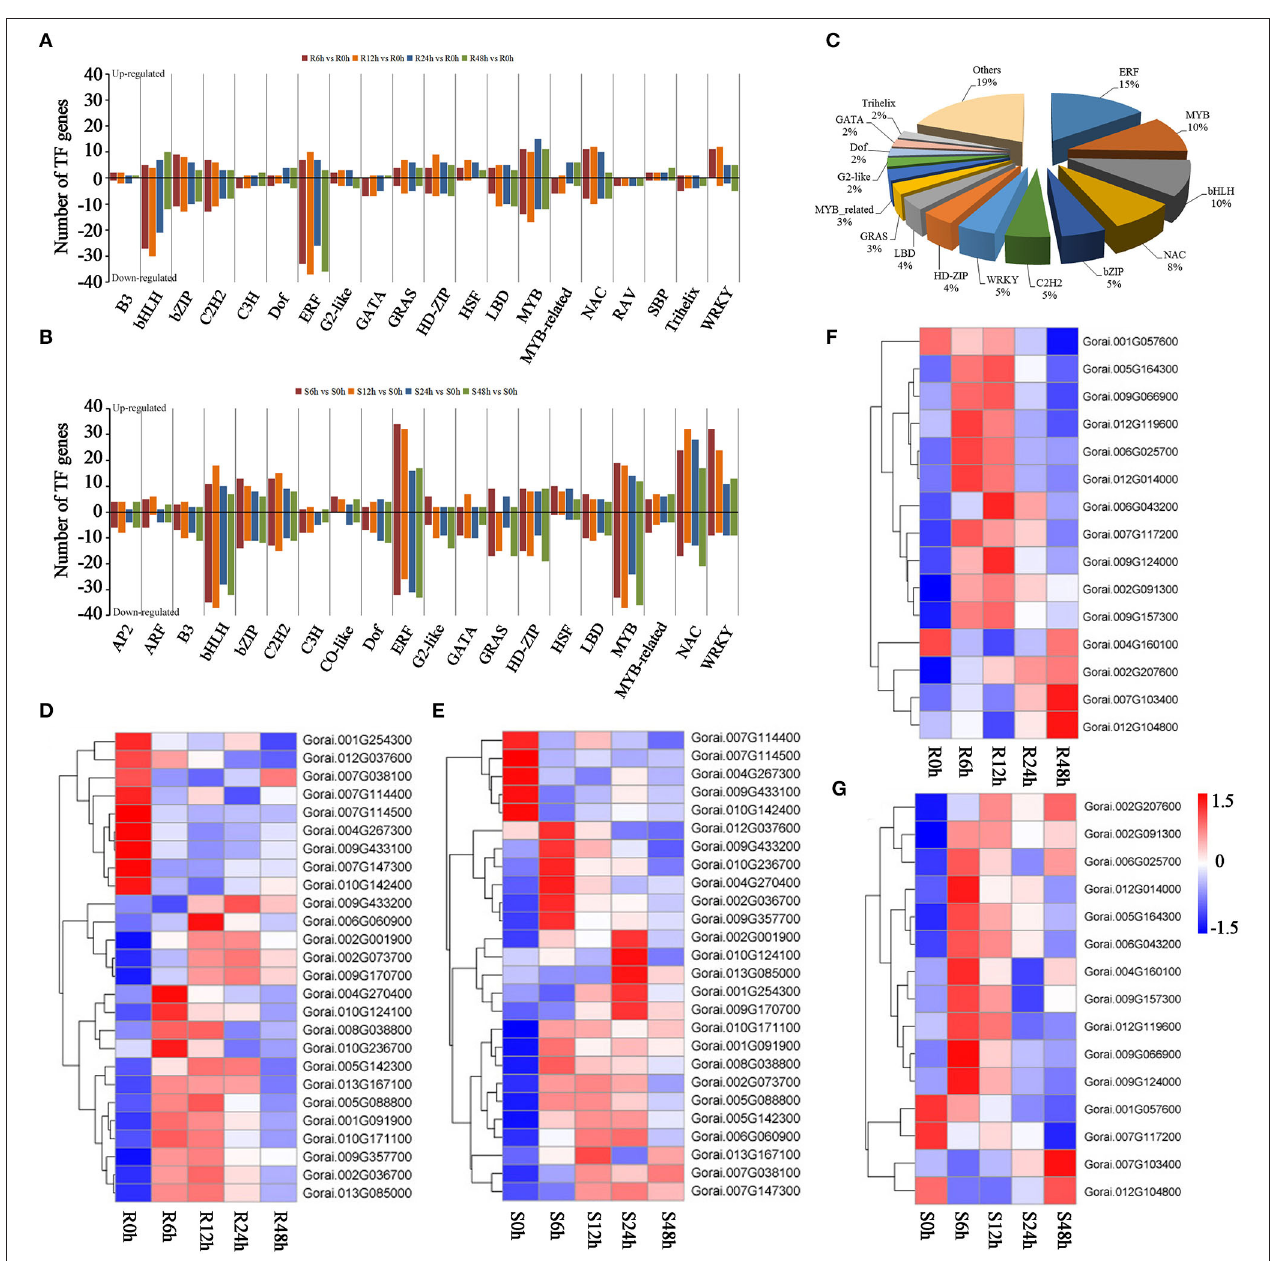
FIGURE 5 | Transcription factors involved in salt tolerance. (A) Enrichment analysis of differentially expressed transcription factors in G. raimondii under salt stress; (B) enrichment analysis of differentially expressed transcription factors in G. sturtianum under salt stress; (C) statistics of common transcription factors in G. raimondii and G. sturtianum ; (D) expression pattern of NAC TFs in G. raimondii ; (E) expression pattern of NAC TFs in G. sturtianum ; (F) expression pattern of WRKY TFs in G. raimondii ; (G) expression pattern of WRKY TFs in G. sturtianum .